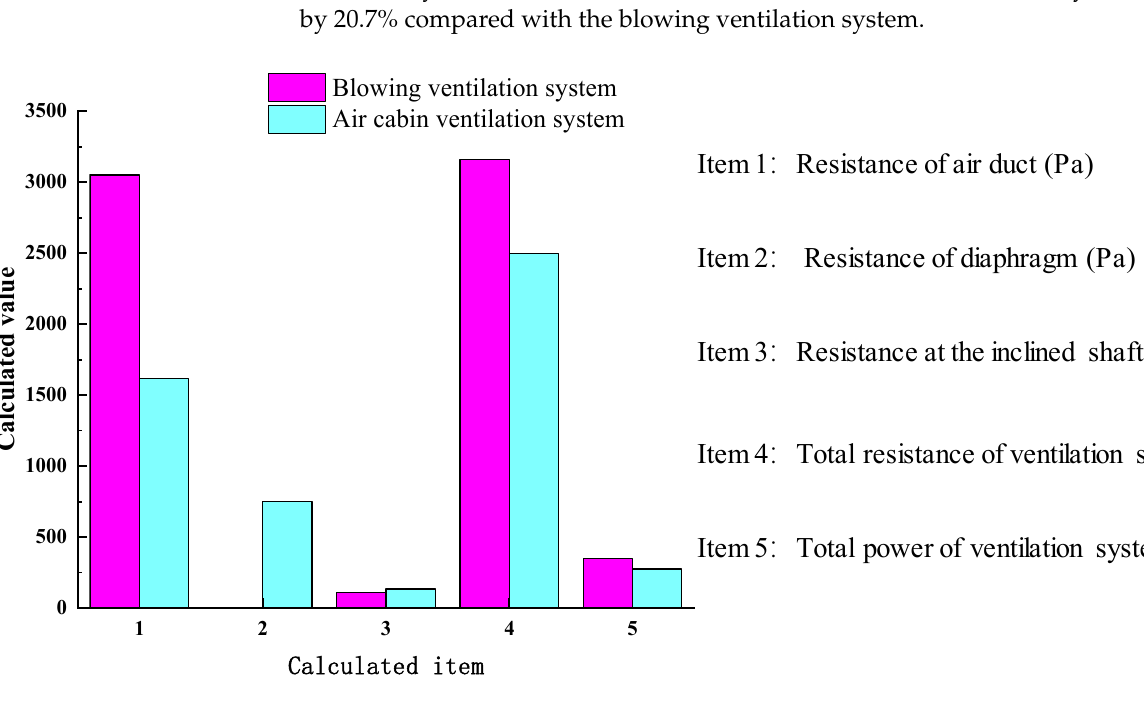
Item 1 ： Resistance of air duct (Pa) Item 2 ： Resistance of diaphragm (Pa) Item 3 ： Resistance at the inclined shaft (Pa)